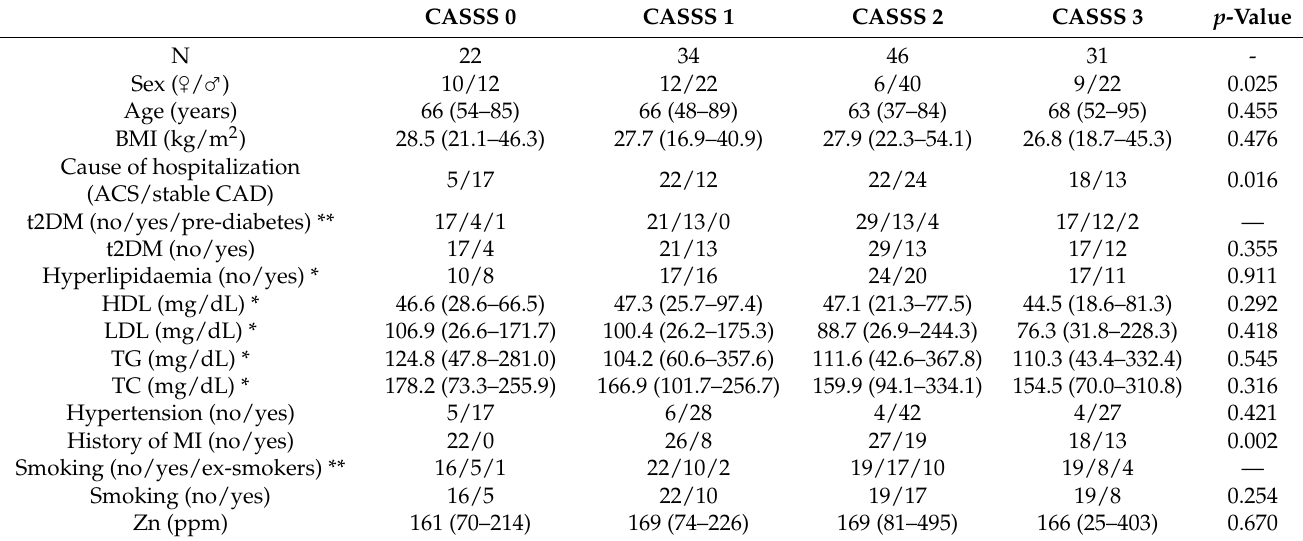
Table 1. Association between selected parameters, including Zn level and CAD stages.